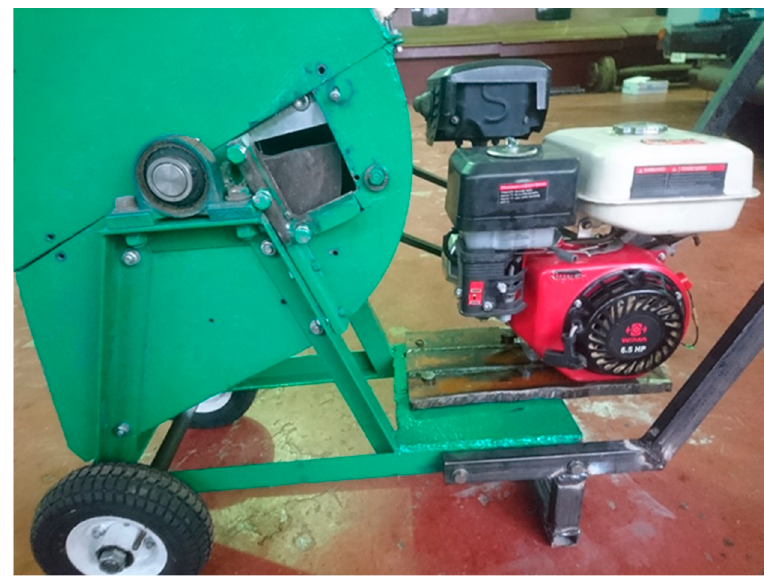
Figure 6. Small mobile biomass shredder.